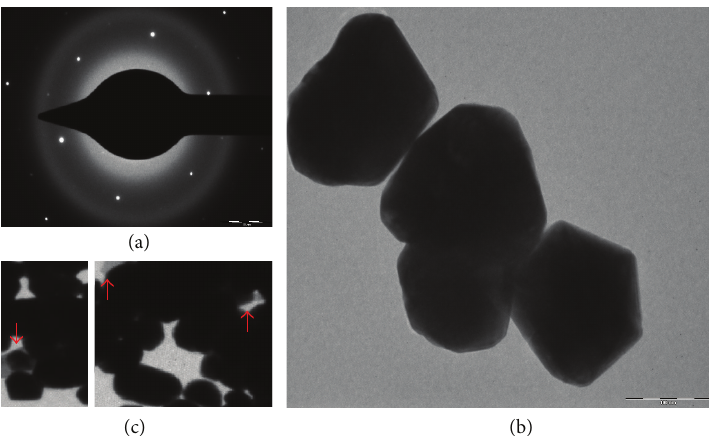
Figure 4: (a) Energy dispersive pattern image of silver nanoparticles. (b) TEM image of synthesized silver nanoparticles. (c) Nanoparticle shownwithredarrowmarkindicatesthepresenceoforganicmoietiesresponsibleforthestabilizationandinterbindingofsilvernanoparticles.